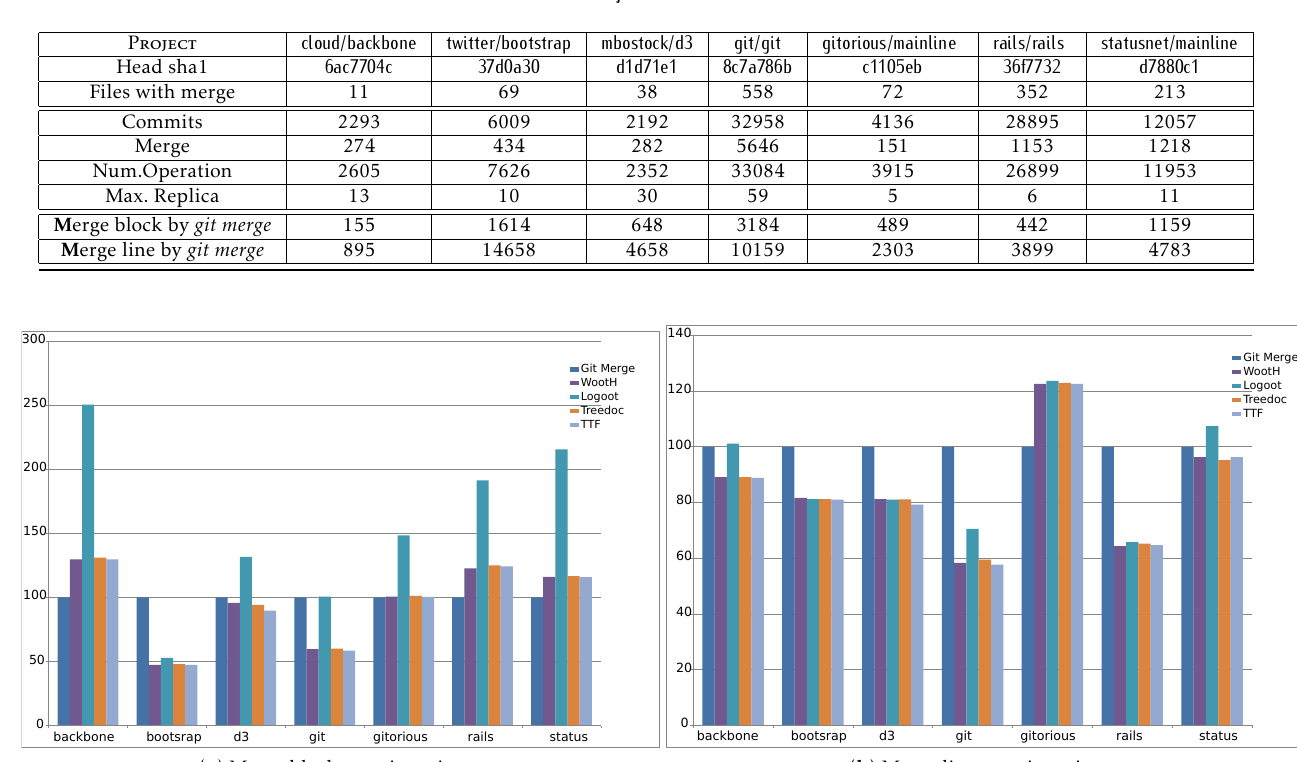
Table 1. Projects characteristics